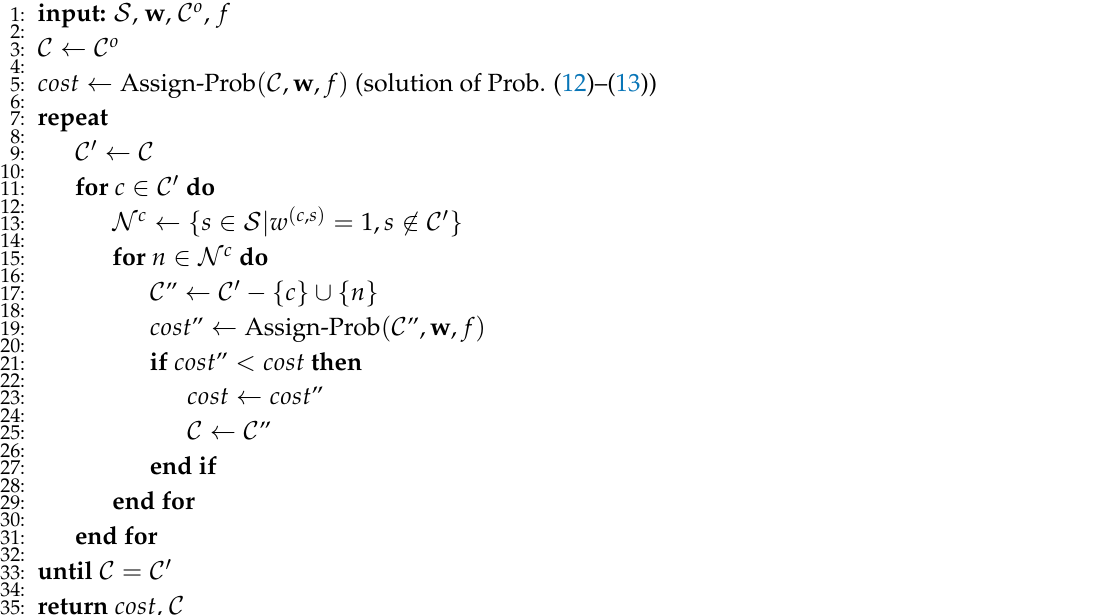
Algorithm 1 Local-search algorithm with fixed number of controllers